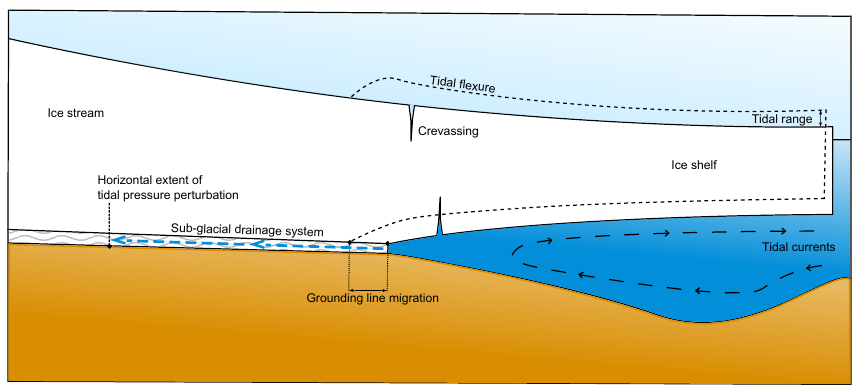
Figure 3. Schematic showing the various mechanisms by which tides can influence ice-stream flow. Note that grounding line migration, crevassing and tidal currents are not included in the